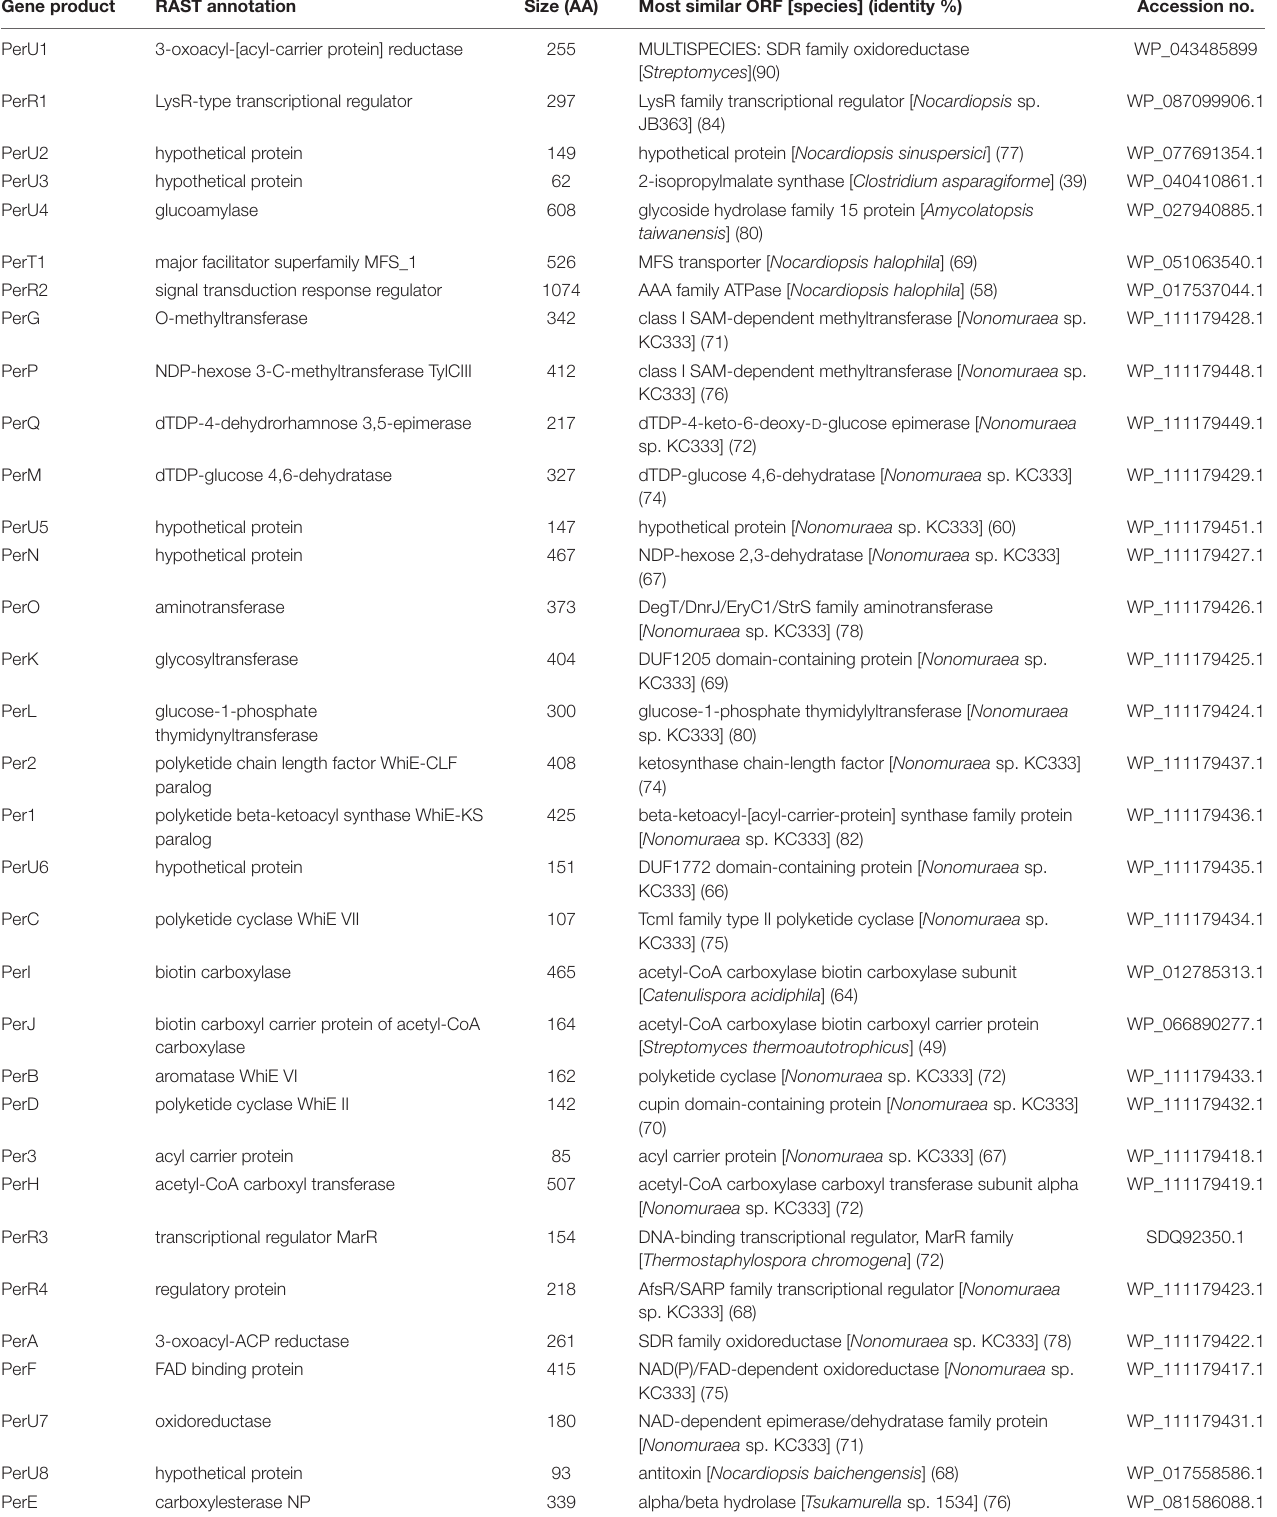
TABLE 1 | Deduced functions of the gene products residing in the persiamycin cluster. Gene product RAST